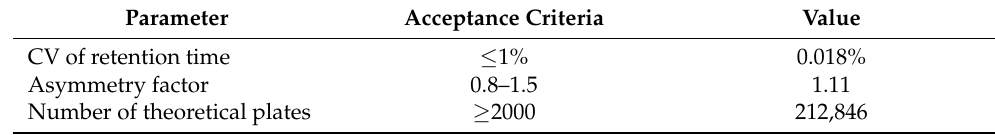
Table 1. System suitability test ( n =